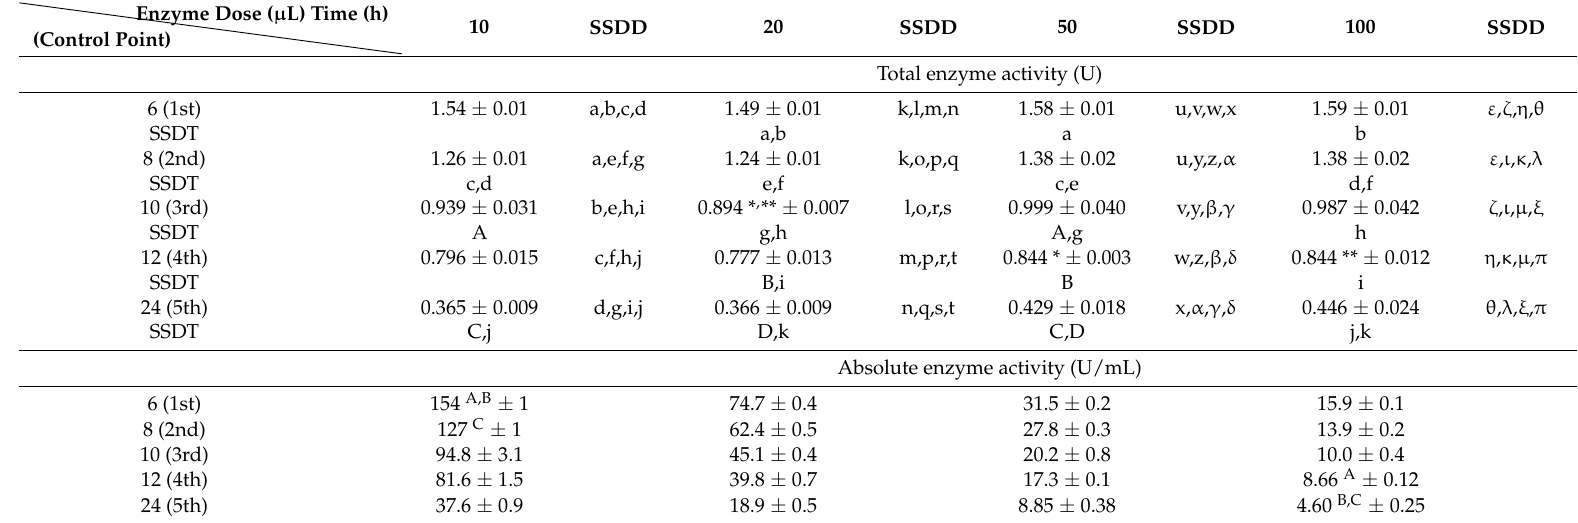
Table 4. Total activity of Celluclast 1.5 at a given control